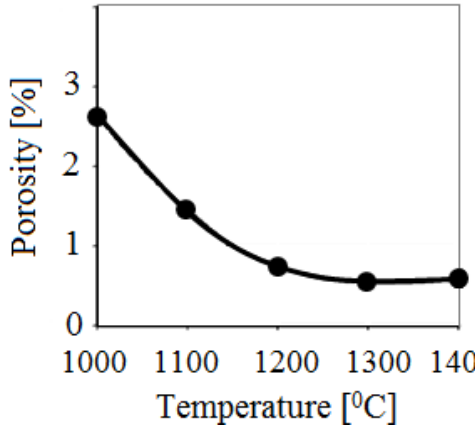
Figure 41. The dependence of the porosity of the Al on the sintering temperature.